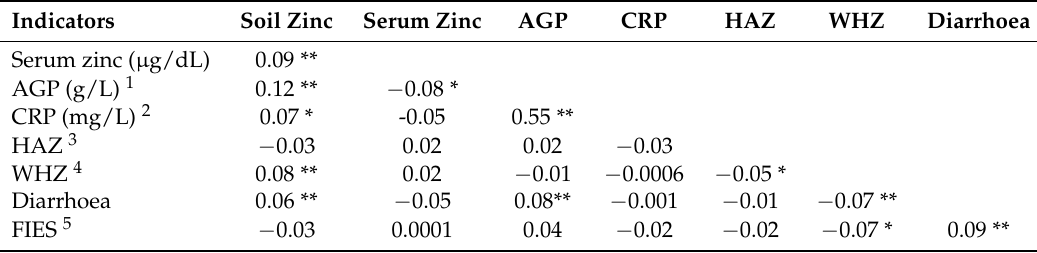
Table 3. Spearman’s rank correlations between soil zinc, serum zinc, inflammation biomarkers child’s growth, incidence of diarrhoea in children and household food insecurity. Indicators